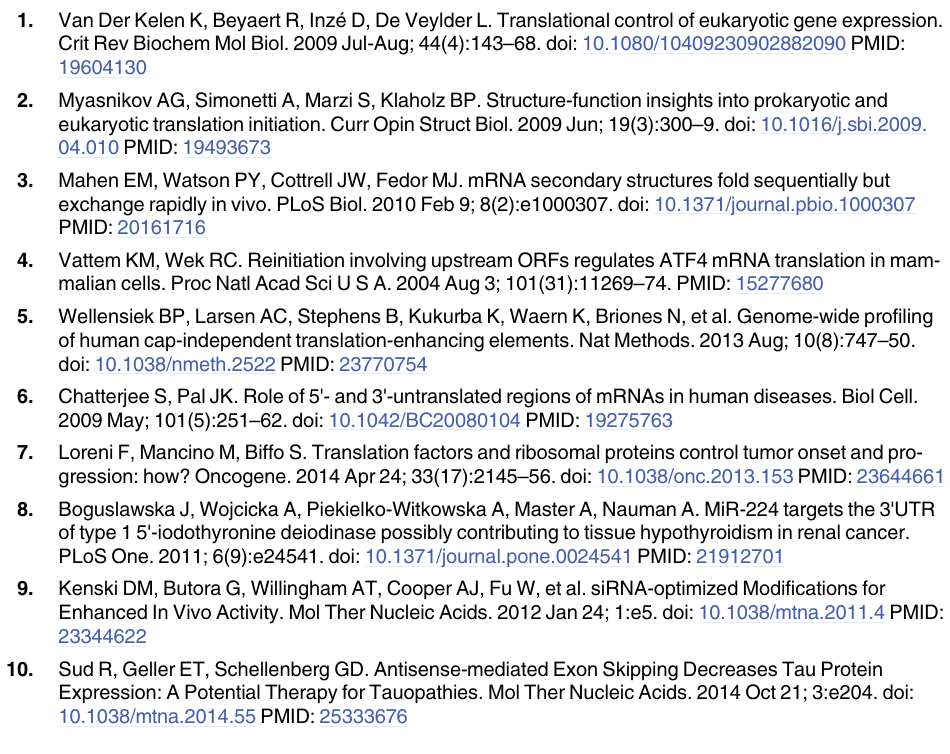
S1 Table. Basic characteristics of selected TR β 1 5 ’ UTR variants A-G. S2 Table. Prediction of translational regulatory potential of 5 ’ UTRs. S3 Table. List of dGoligos (dGs) used in the study. S4 Table. List of primers used in Real-Time and classic